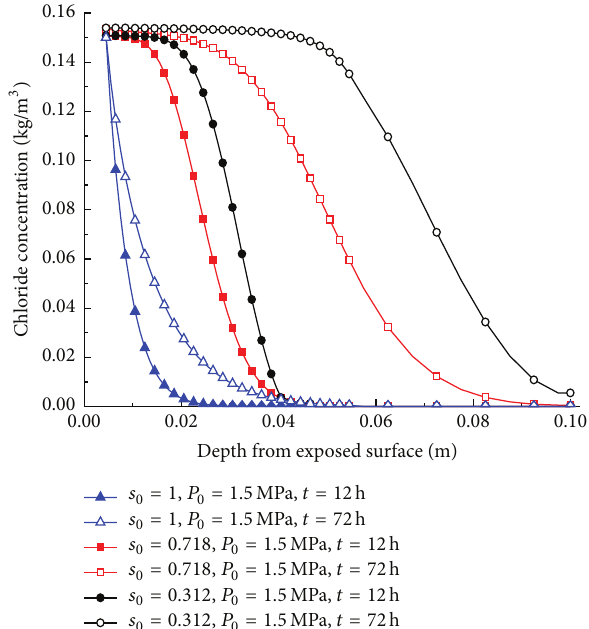
Figure 10: Chloride concentration simulation under different initial